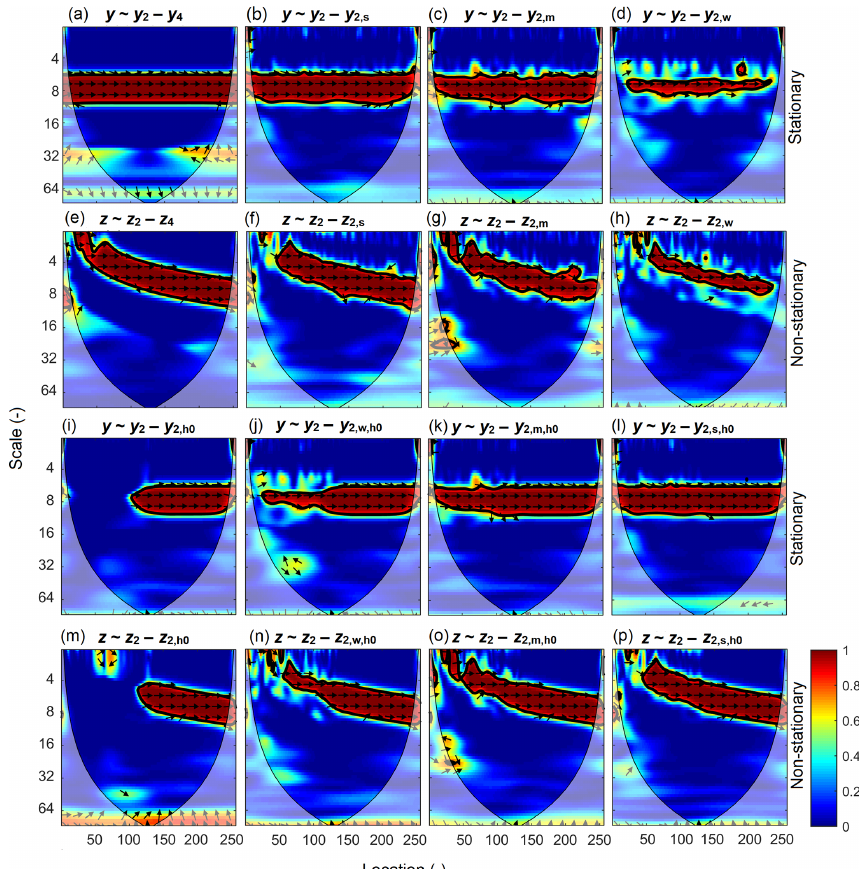
Figure 1. Partial wavelet coherency (PWC) between response variable y (or z ) and predictor variable y 2 (or z 2 ) after excluding the effect of variables y 4 (or z 4 ), y 2 , s (or z 2 , s ), y 2 , m (or z 2 , m ), y 2 , w (or z 2 , w ), y 2 , h0 (or z 2 , h0 ), y 2 , w , h0 (or z 2 , w , h0 ), y 2 , m , h0 (or z 2 , m , h0 ), and y 2 , s , h0 (or z 2 , s , h0 ) for the stationary (or non-stationary) case using the new method. Arrows represent the phase angles of the cross-wavelet power spectra between two variables after eliminating the effect of excluding variables. Arrows pointing to the right (left) indicate positive (negative) correlations. Thin and thick solid lines show the cones of influence and the 95% confidence levels, respectively. All variables were generated by following Yan and Gao (2007) and Hu and Si (2016) and are explained in Sect 3.1 and shown in Fig. S2 of Sect. S3 in the